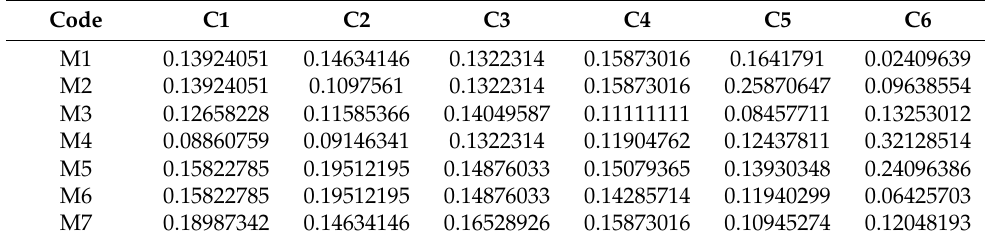
Table 22. Decision matrix normalized